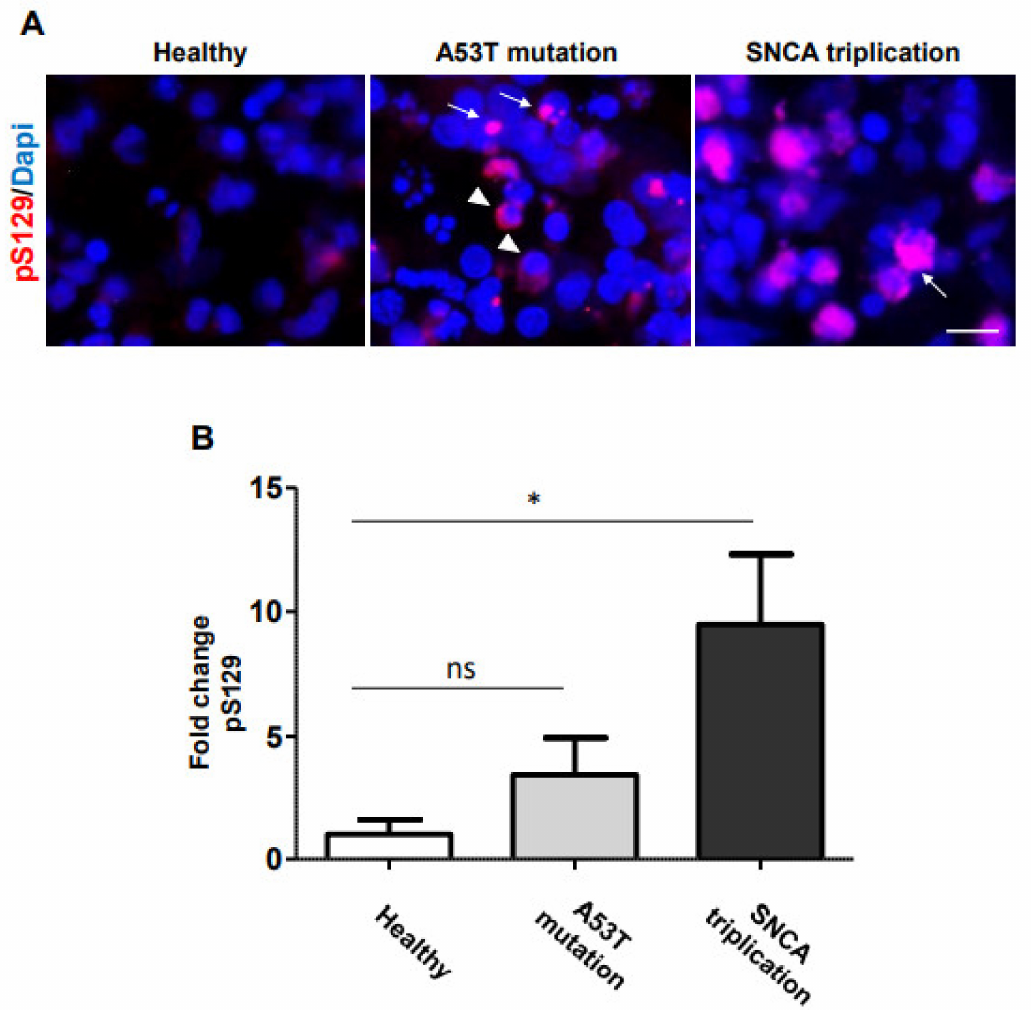
Figure 4. Accumulation of phosphorylated α -syn in mDA neuronal culture from fPD patient. ( A ) Seventy-day-old DA neuronal cultures from healthy and fPD lines were immunostained with an antibody against phosphorylated α -syn at serine 129 residue, a marker of LBs. The punctated accumulation of pathological α -syn next to the nucleus, resembling LBs, is indicated by an arrow, and diffuse pS129 immunostaining, resembling the early stage of LBs, is indicated by an arrowhead. ( B ) Levels of pS129 immunostaining were quantified using image analysis. Images are representative of at least three independent differentiations. All data in ( B ) are presented as mean ± SEM of three images acquired from three different coverslips. Data were analyzed by one-way ANOVA followed by Tukey’s multiple comparison post hoc test. * p < 0.05. The scale bar is 10 µ